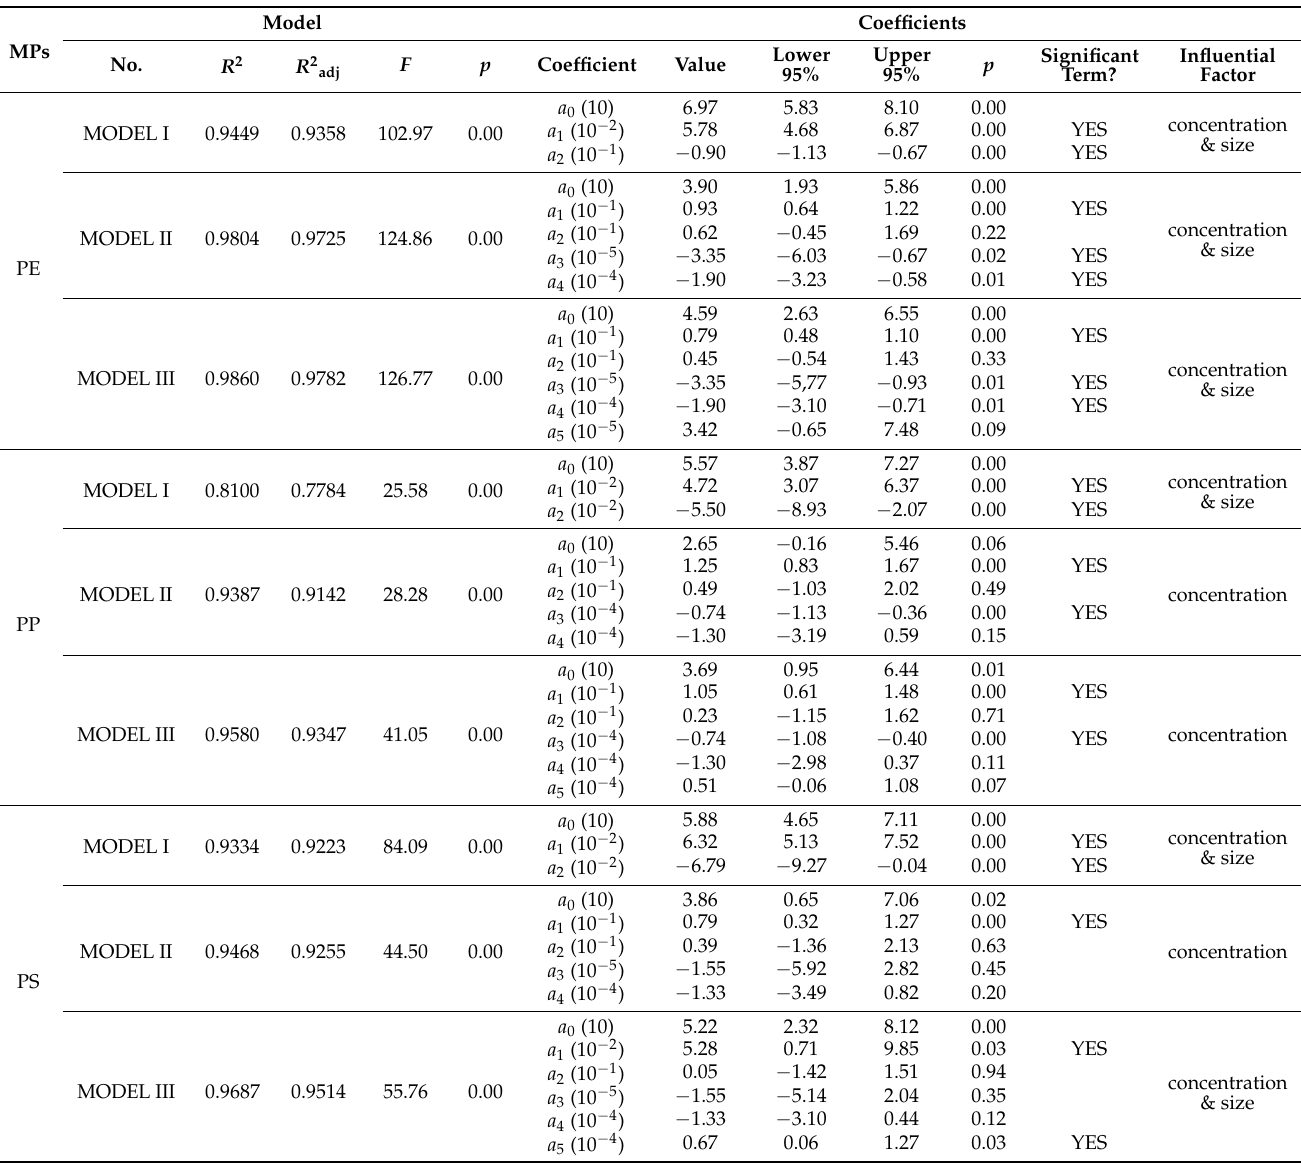
Table 4. Statistical analysis of the regression models (Equations (3)–(5)) for the yeast Saccharomyces cerevisiae . The yeast was exposed to microplastics (MPs) particles of: polyethylene (PE), polypropylene (PP), polystyrene (PS), polyvinyl chloride (PVC), and polyethylene terephthalate (PET). The analyzed factors were concentration and size of the